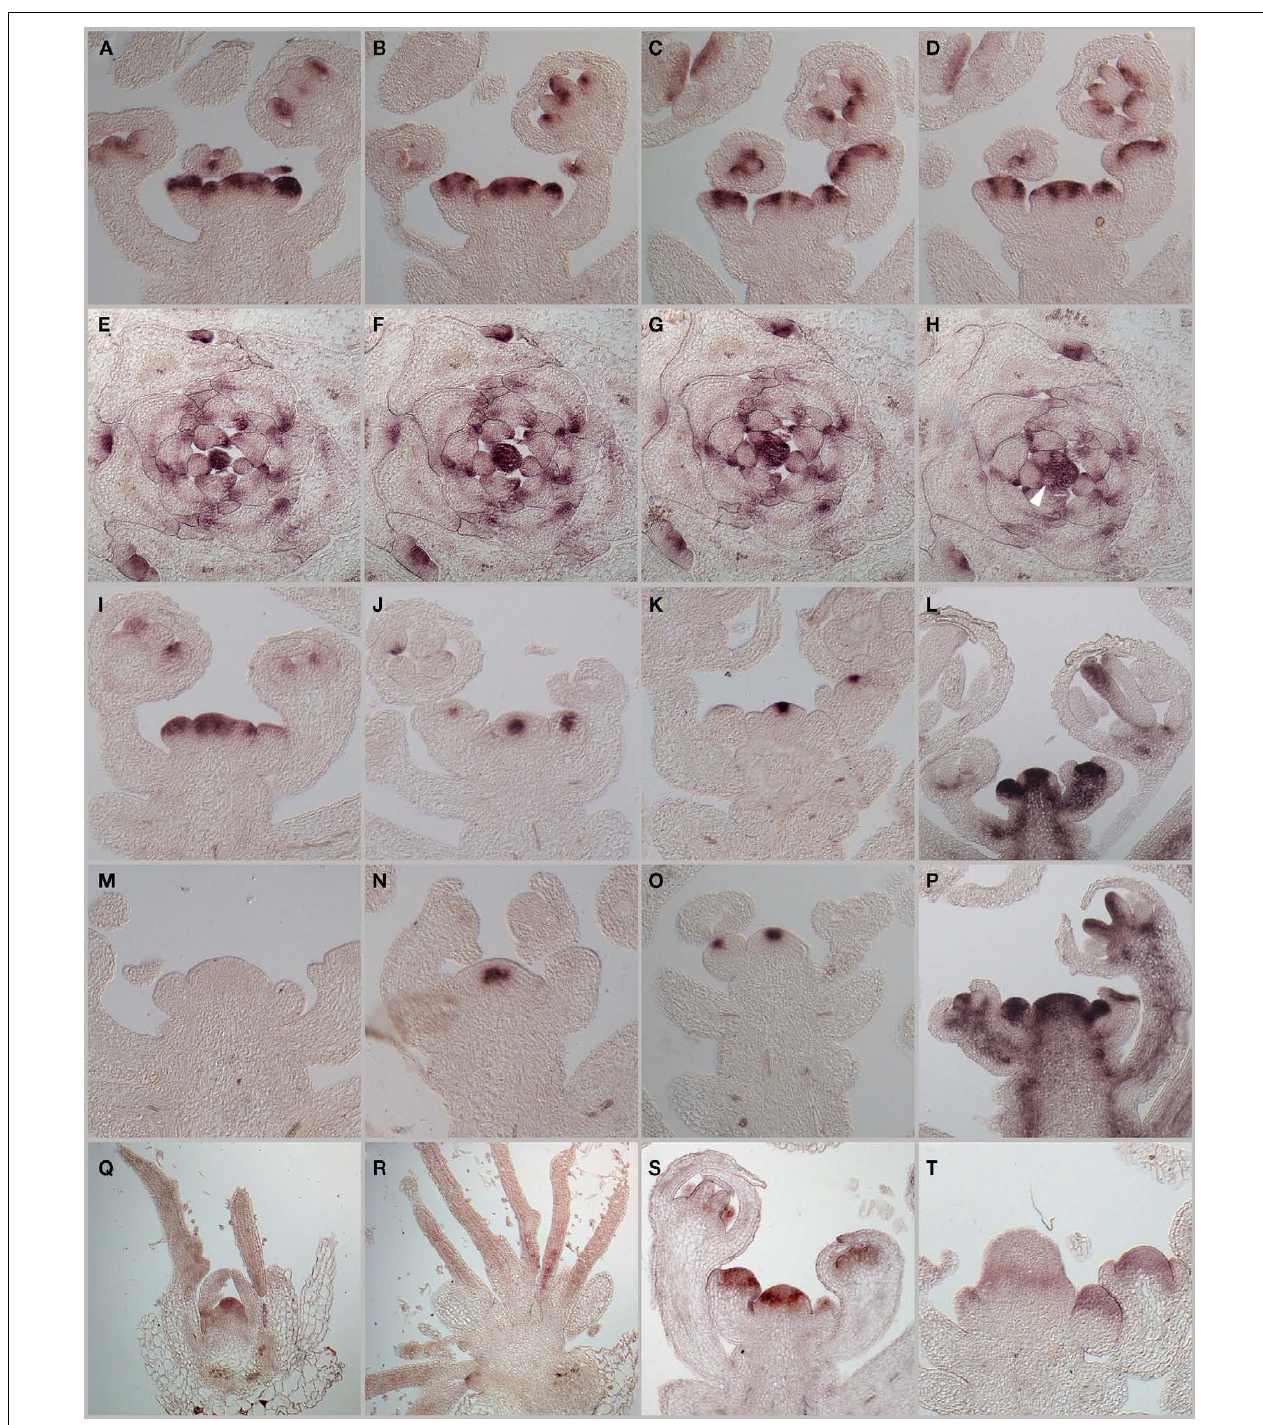
in newly arising organ primordia [P3-P0, see arrowhead in (H) ]. Expression patterns of PAN , WUS , CLV3 , and STM in inflorescence apices of wild-type (I–L) and pan mutant plants (M–P) . PAN (I,M) , WUS (J,N) , CLV3 (K,O) , and STM (L,P) . PAN mRNA-expression in vegetative tissues of wild-type (Q) and wus mutants (R) . PAN expression in wild-type (S) and ring-like expression in enlarged floral tissues on clv3 mutant (T)